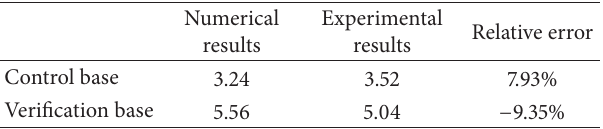
Table 6: Comparison of numerical and experimental results of the vibration level difference